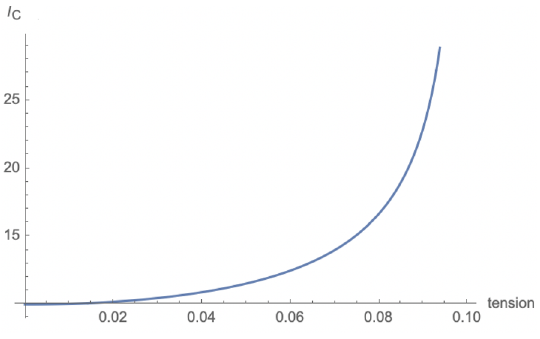
Figure 6 . log g has a finite maximum value when l C > l L ( l L = l R = 10 and τ 1 = τ 2 )